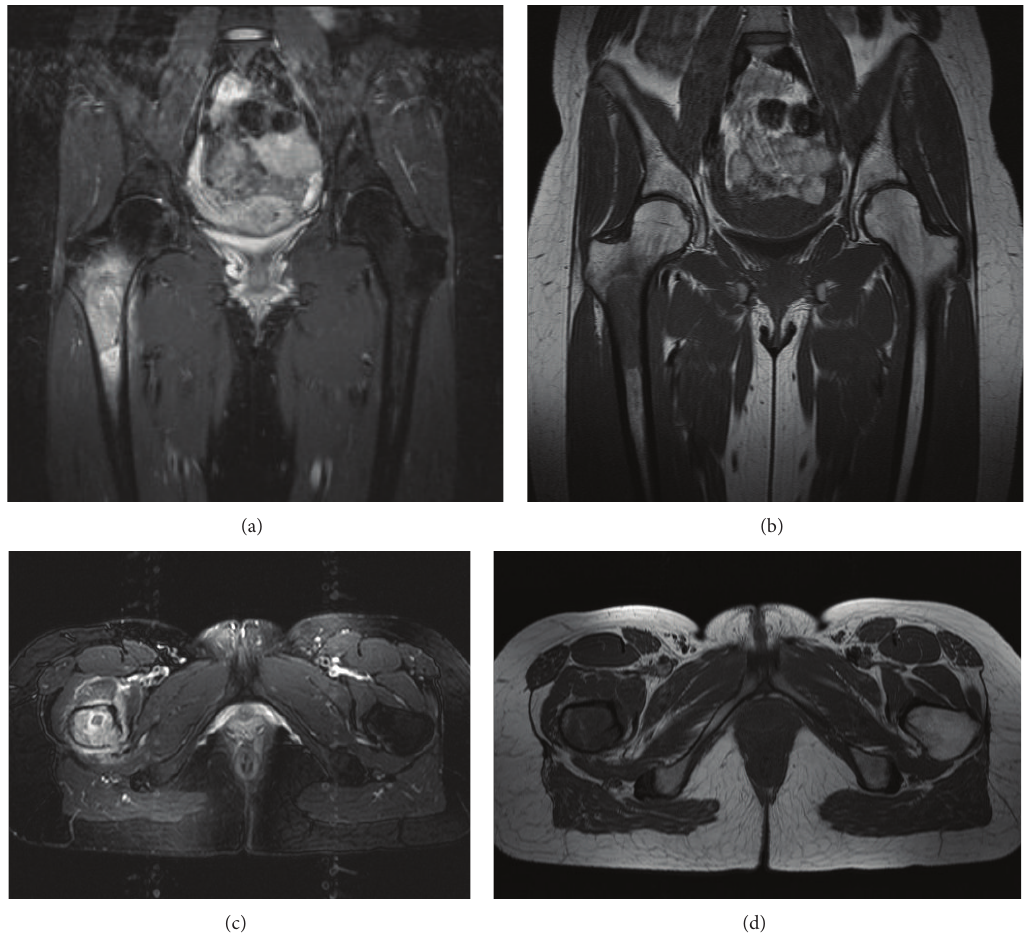
Figure 2: Unenhanced MRI of the right hip reveals a hyperintense lesion on STIR sequence ((a) coronal and (c) axial) and a correspondingly hypointense lesion on TI-weighted sequence ((b) coronal and (d) axial) with minimal cortical bone changes and no soft-tissue